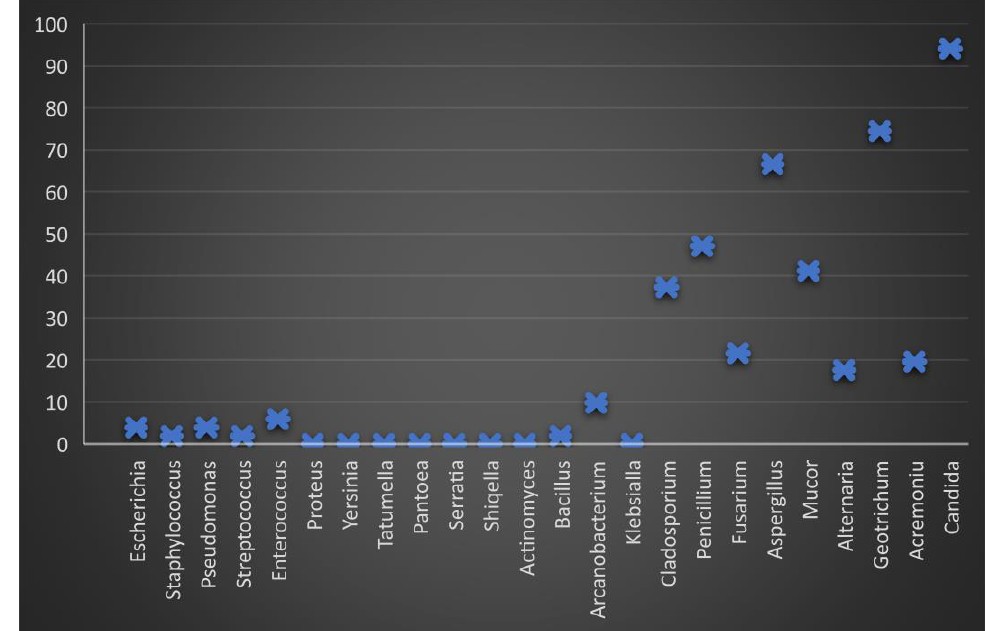
Figure 2. Graphic representation of the percentage of microbiological load in boar semen 24 h after dilution and storage at 17 ◦ C. The minimum level of bacterial load is observed, but the fungal load remains constant, especially the genus Candida